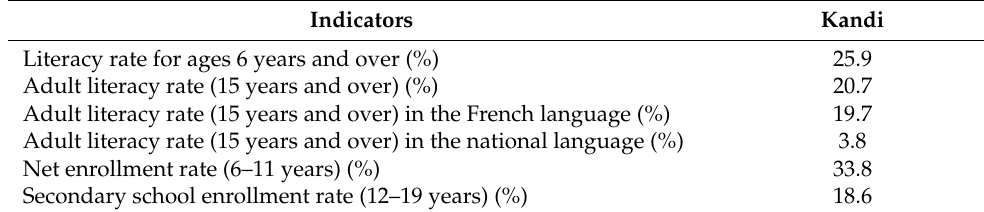
Table 1. Literacy and education of the community. Indicators Kandi Literacy rate for ages 6 years and over